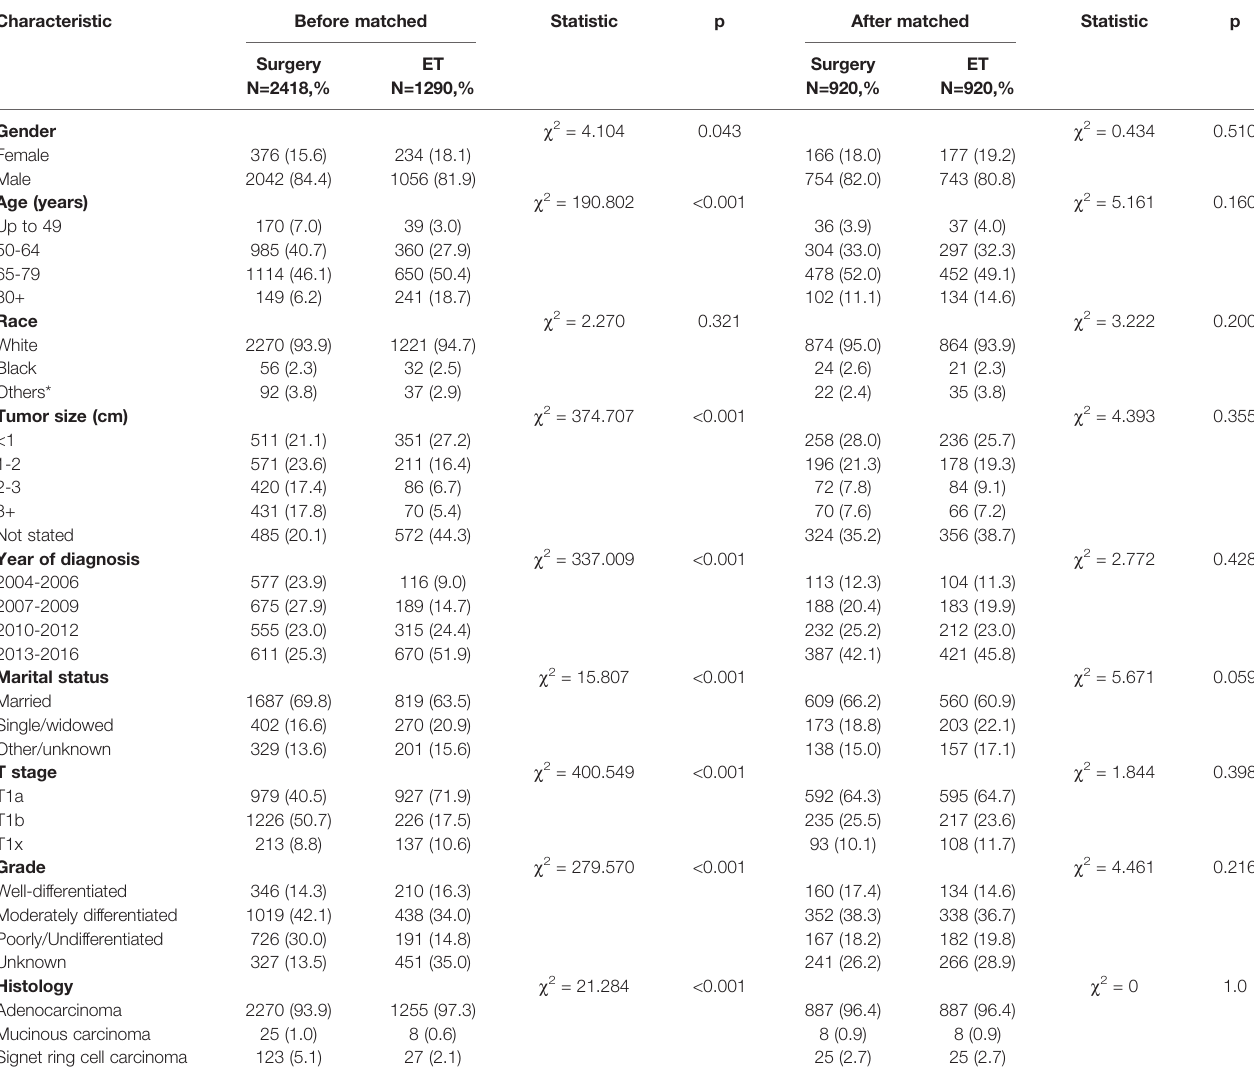
TABLE 1 | Baseline characteristics of patients treated with ES and ET for early-stage esophageal cancer before and after the propensity score-matched (1:1 matching). Characteristic Before matched Statistic p After matched Statistic p Surgery